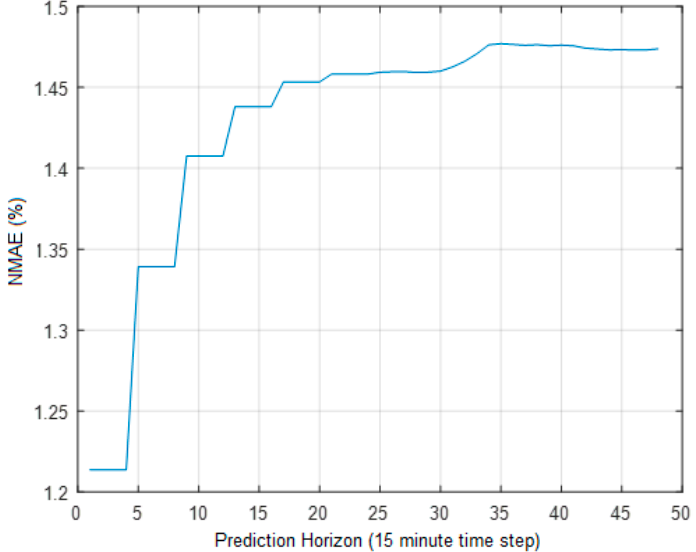
Figure 14. Normalized mean absolute error (NMAE, in %) of the PV power within the prediction horizon.